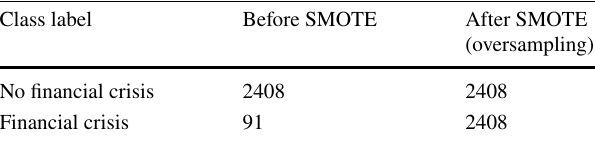
Table 1 The count of samples in the used dataset before and after SMOTE